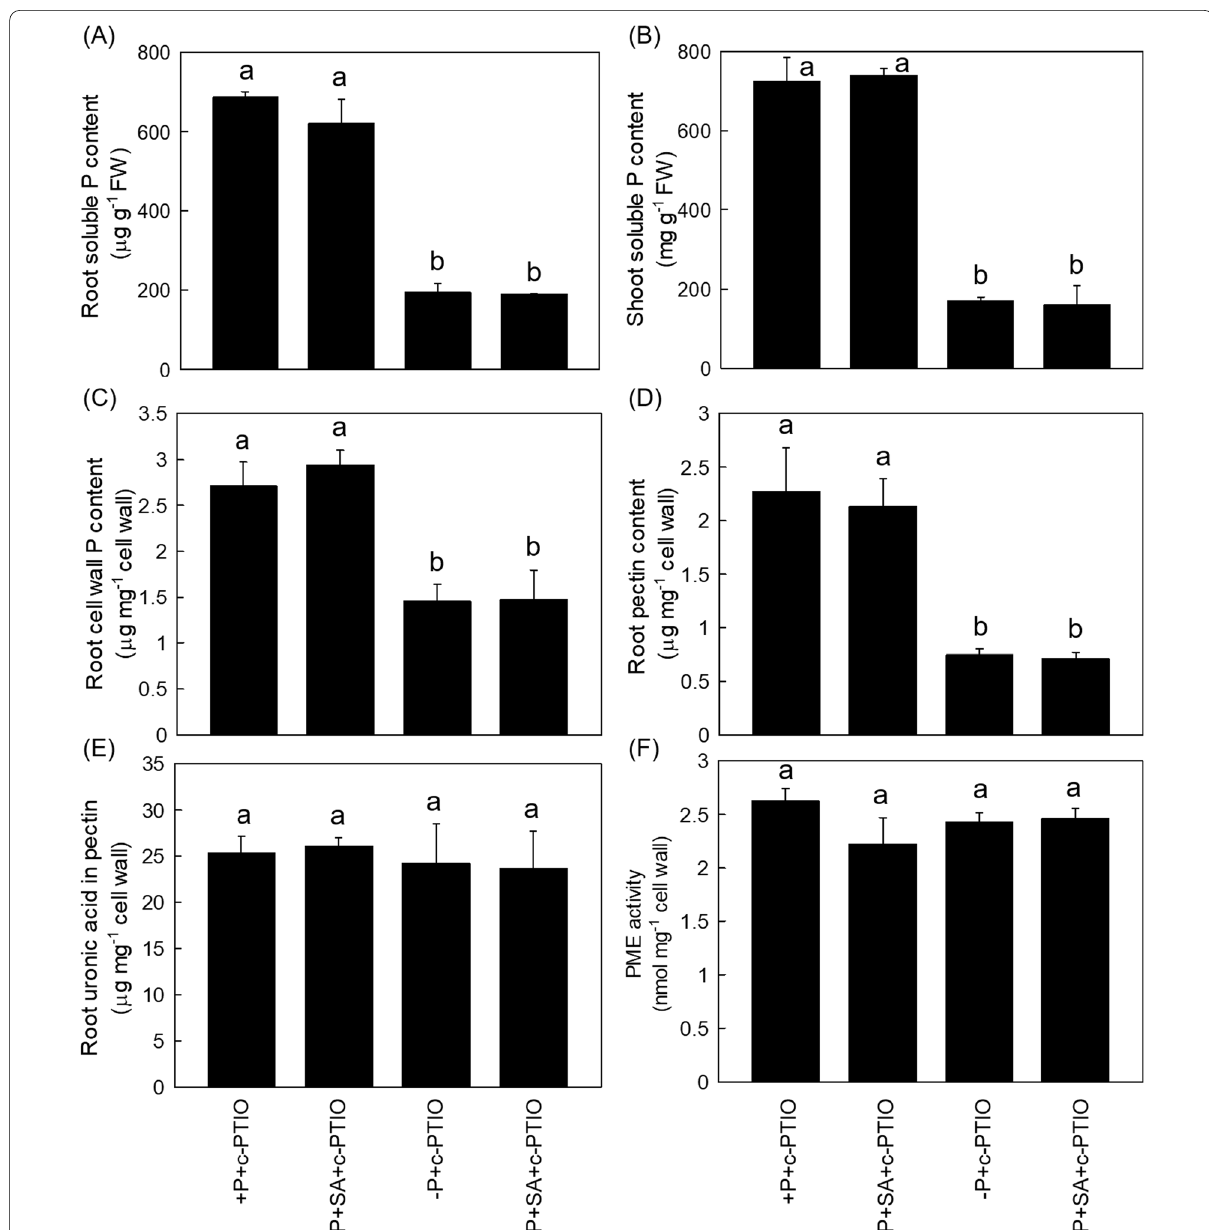
Fig. 7 SA promoted root cell wall P reutilization in rice is dependent on NO. Soluble P content in root ( A ) and shoot ( B ), root cell wall P content ( C ), cell wall pectin P content ( D ), root pectin content ( E ) and PME activity ( F ) were measured. Data are means significant differences by Duncan’s multiple range test at the P <